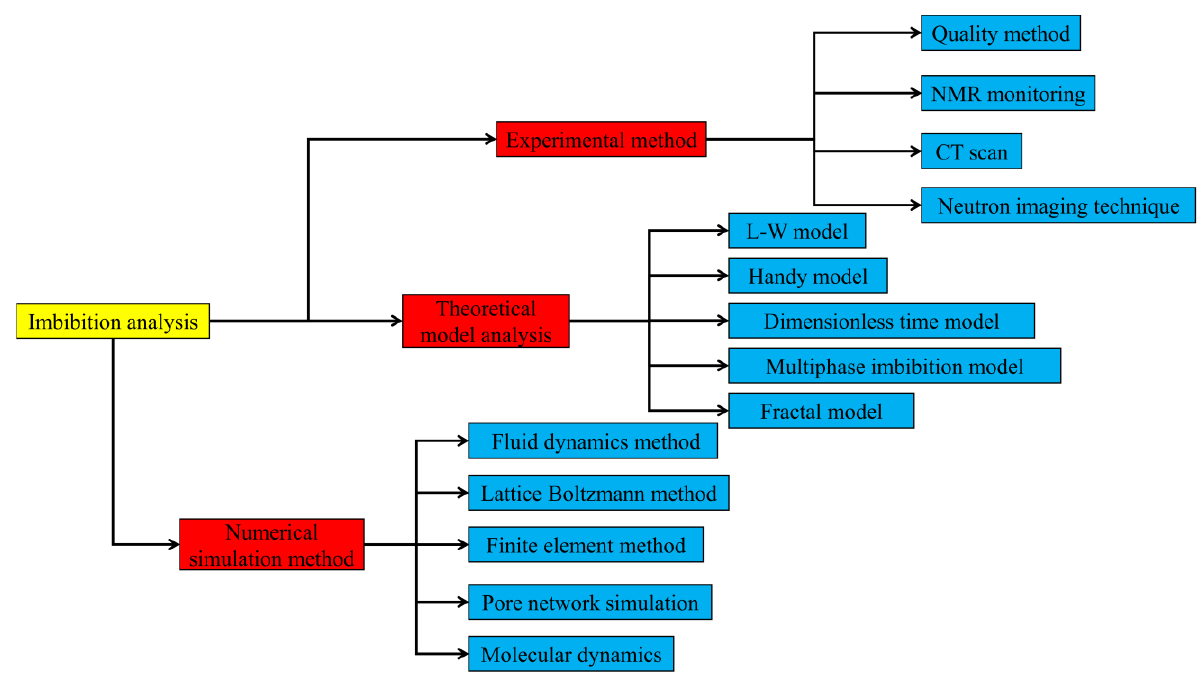
Figure 8. Approaches of different categories for imbibition study.